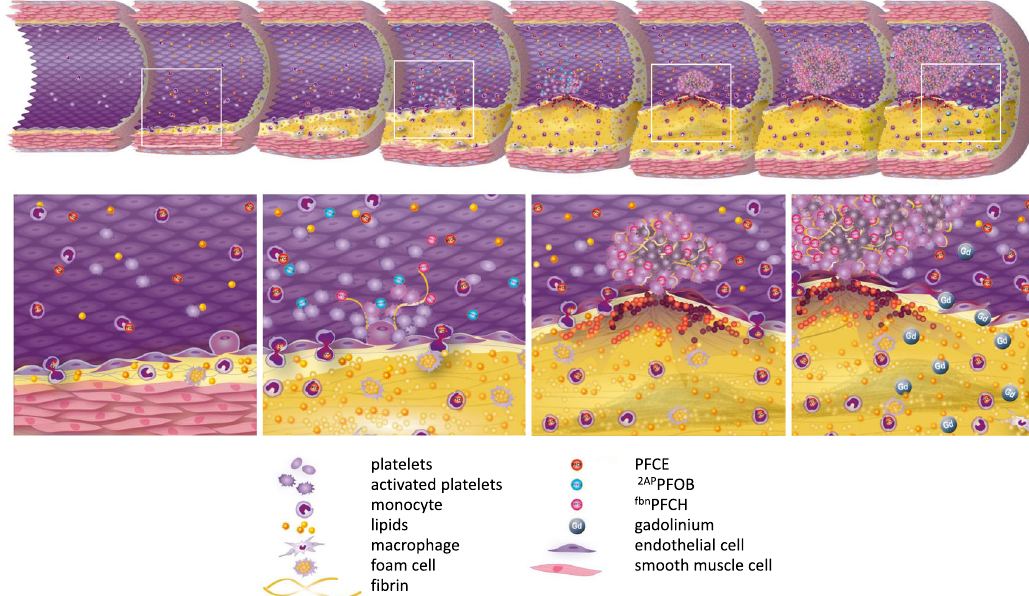
Fig. 6 Unmasking of emerging danger patterns by multi-targeted PFCs. Schematic drawing of the pathophysiological cascade from beginning coronary continuum from coronary in fl ammation to occlusion in HypoE mice upon exposure to atherogenic high-fat diet. White rectangles indicate the magni fi